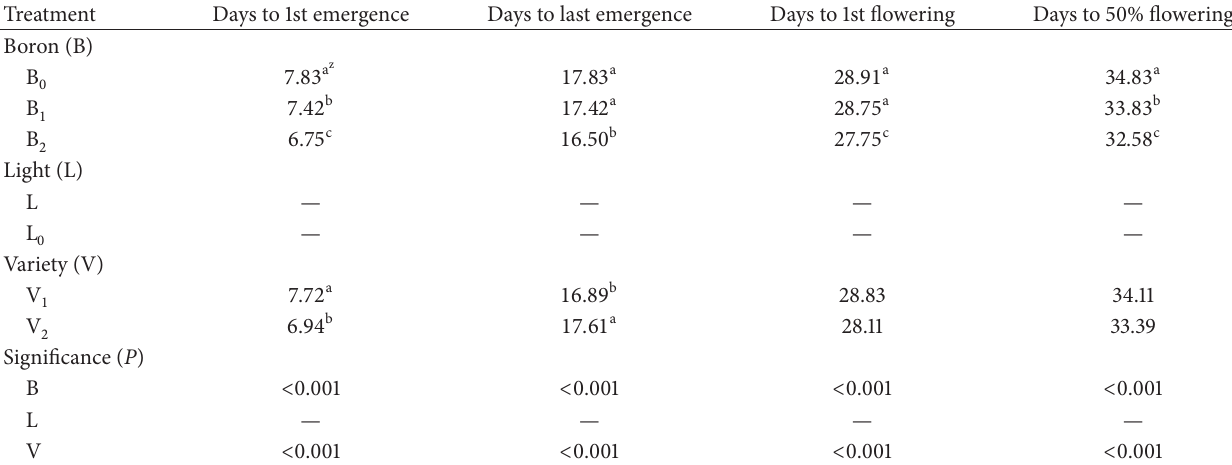
Table 2: Effect of boron and light on days to emergence and days to flowering in two peanut varieties (mean of two trials).